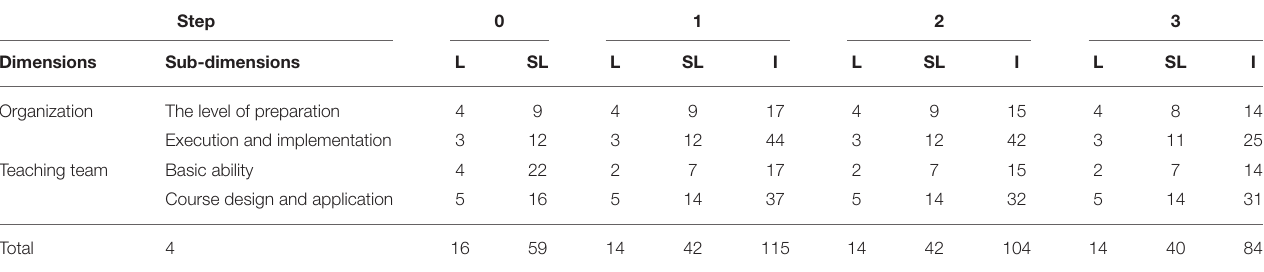
TABLE 1 | Number of adjusted contents in the e-learning knowledge